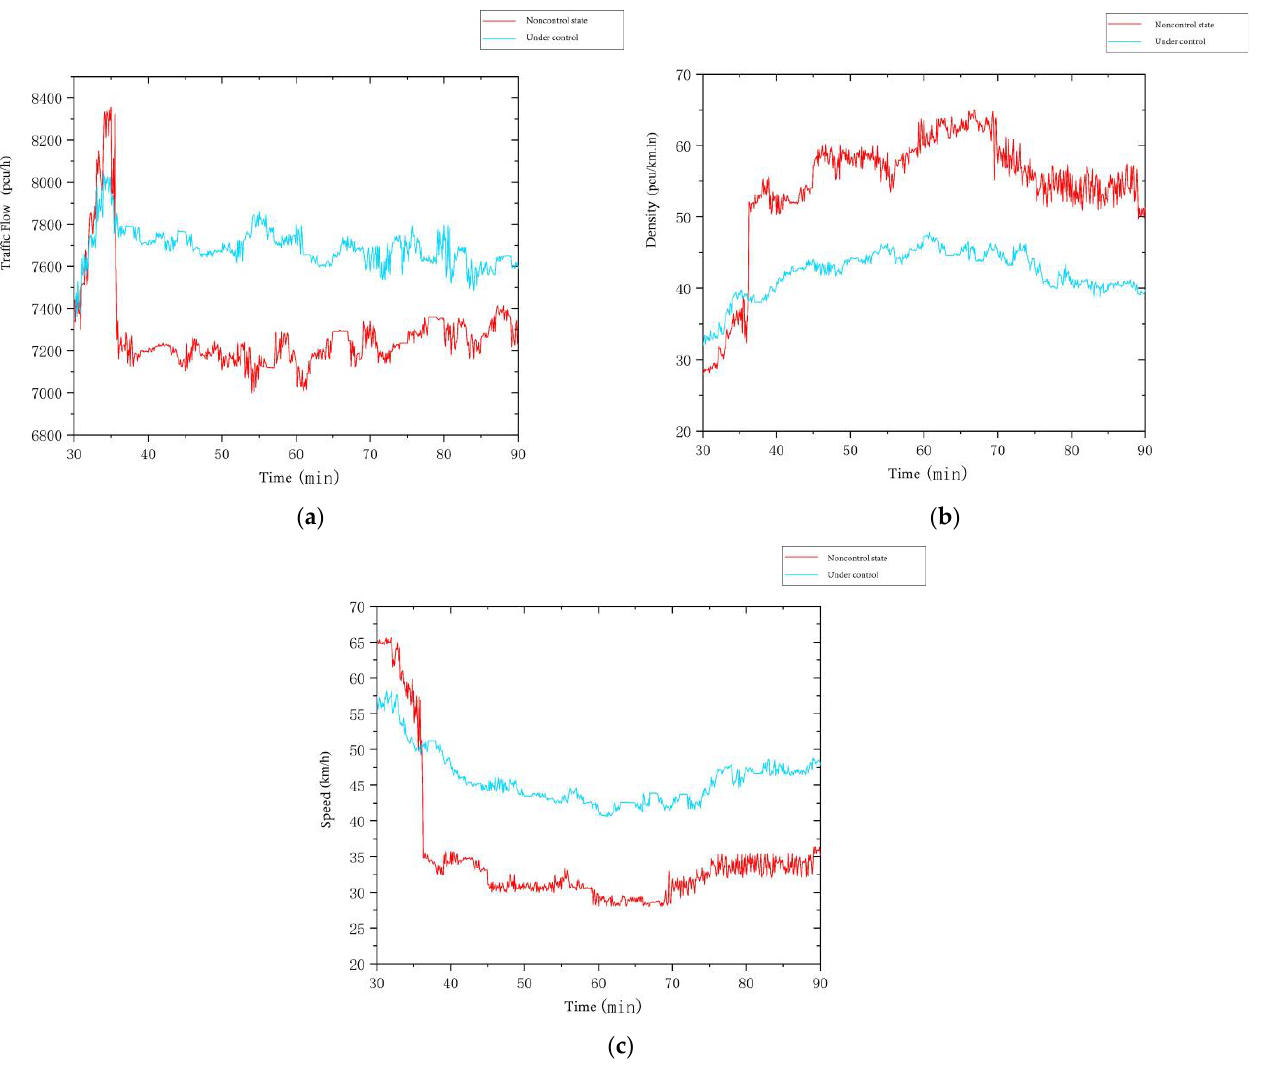
Figure 17. VISSIM output results after the implementation of collaborative control. ( a ) Traffic flow; ( b ) Traffic flow speed; ( c ) Control parameter output.